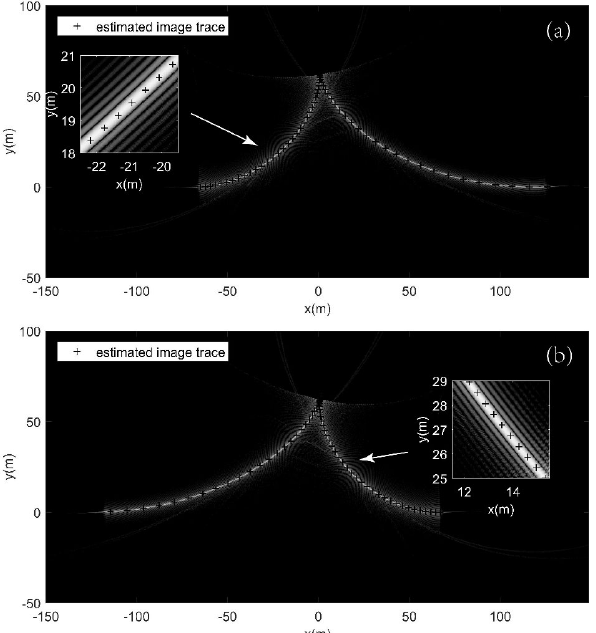
Figure 15. Estimated image trace and moving target SAR image. ( a , b ) are deceleration target and acceleration target,